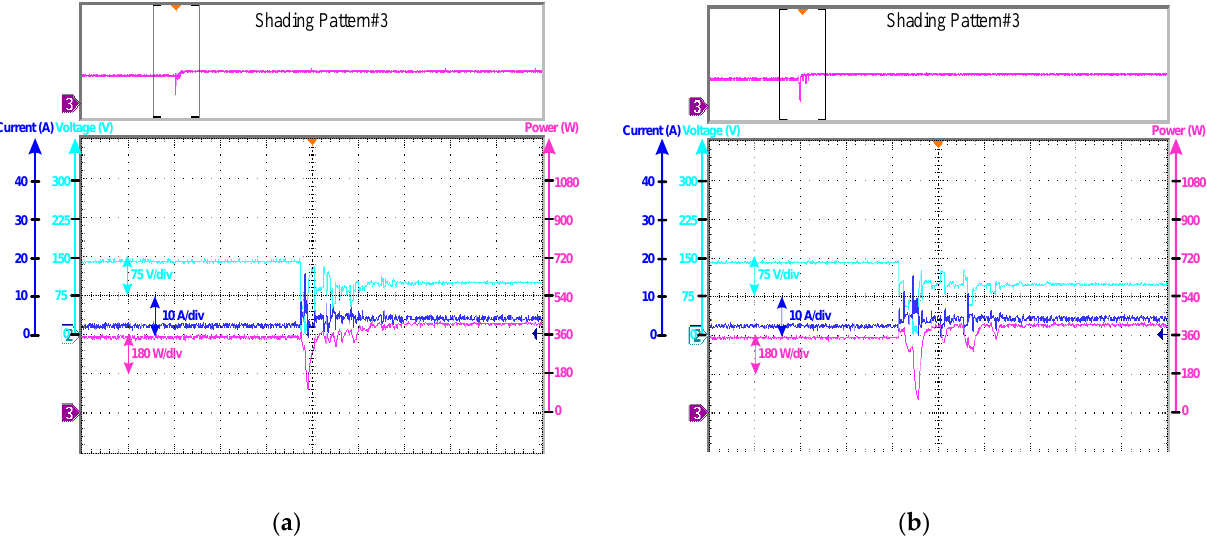
Figure 11. Experimental results of output power and voltage of the SP#2 using: ( a ) CSO; ( b ) PSO.